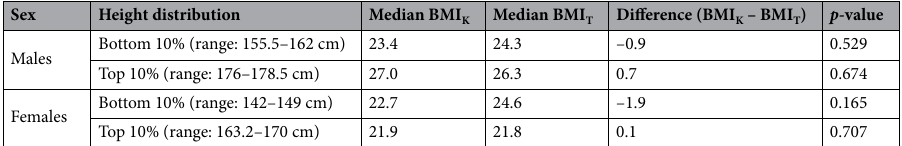
Table 2. Comparison of the body mass index (BMI) values at the bottom and top 10% of the height distribution. BMI T BMI calculated using the proposed modified (Trefethen) formula, BMI K BMI calculated using the Quetelet index popularized by keys.